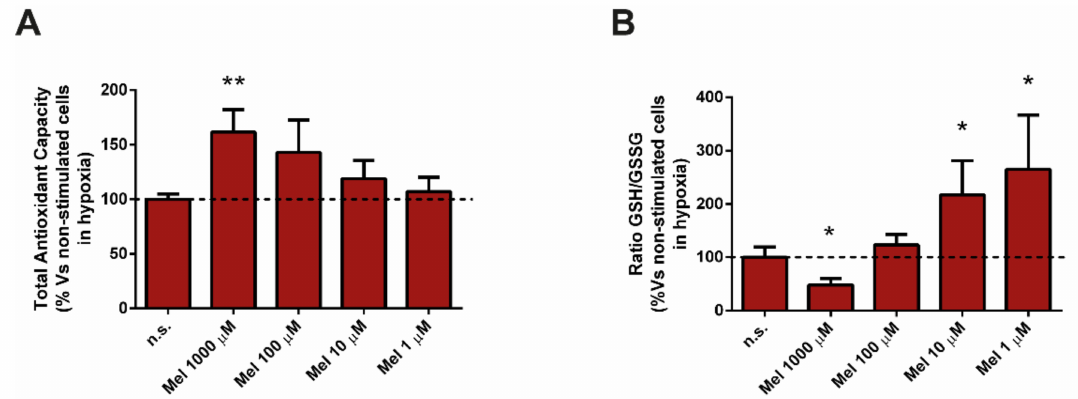
Figure 4. Effect of melatonin on glutathione and on total antioxidant capacity. PSC were incubated with melatonin (1000 µ M, 100 µ M, 10 µ M, or 1 µ M) under hypoxia during 4 h. ( A ) Total antioxidant capacity (TAC) of the cells was determined. ( B ) The ratio of GSH/GSSG was studied. Values are the mean ± S.E.M. of normalized values expressed as % with respect to cells incubated under hypoxia, but in the absence of melatonin (non-treated cells). A horizontal dashed line represents the value observed in non-treated cells. Data are representative of five independent experiments (n.s., non-treated cells; Mel, melatonin; H 2 O 2 , hydrogen peroxide; *, p < 0.05; and **, p < 0.01 vs. non-treated cells in